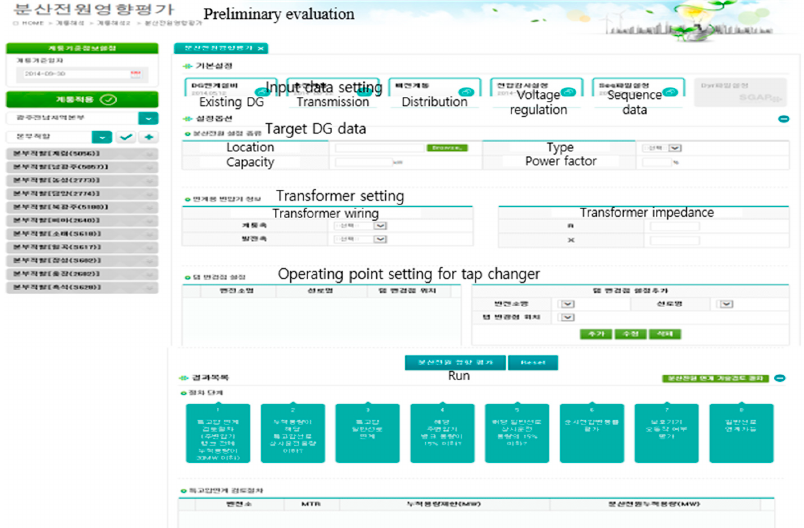
Figure 4. Input screen for a preliminary evaluation of the DG connection in the networked version.